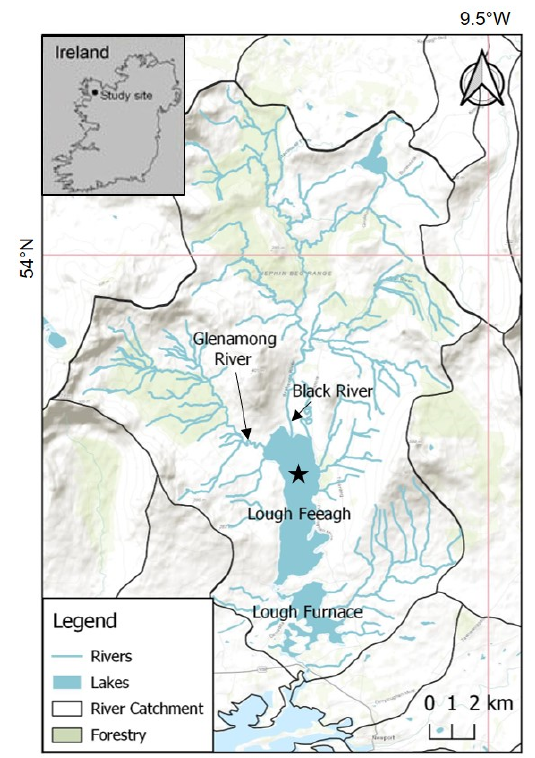
Figure 1. Map of Burrishoole catchment. The star on Lough Feeagh indicates the sample site (Esri base map [34]).